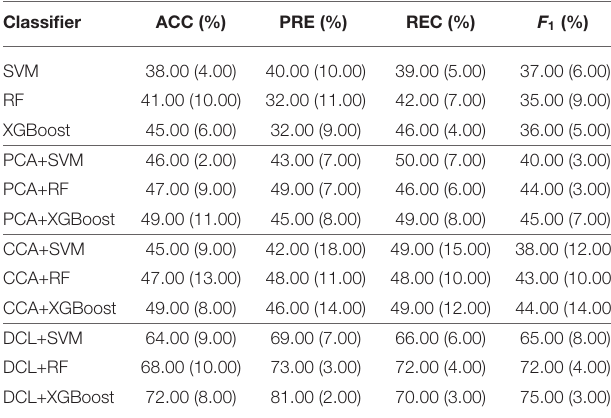
TABLE 2 | Mean values in the evaluation of the classification performance on the CNP